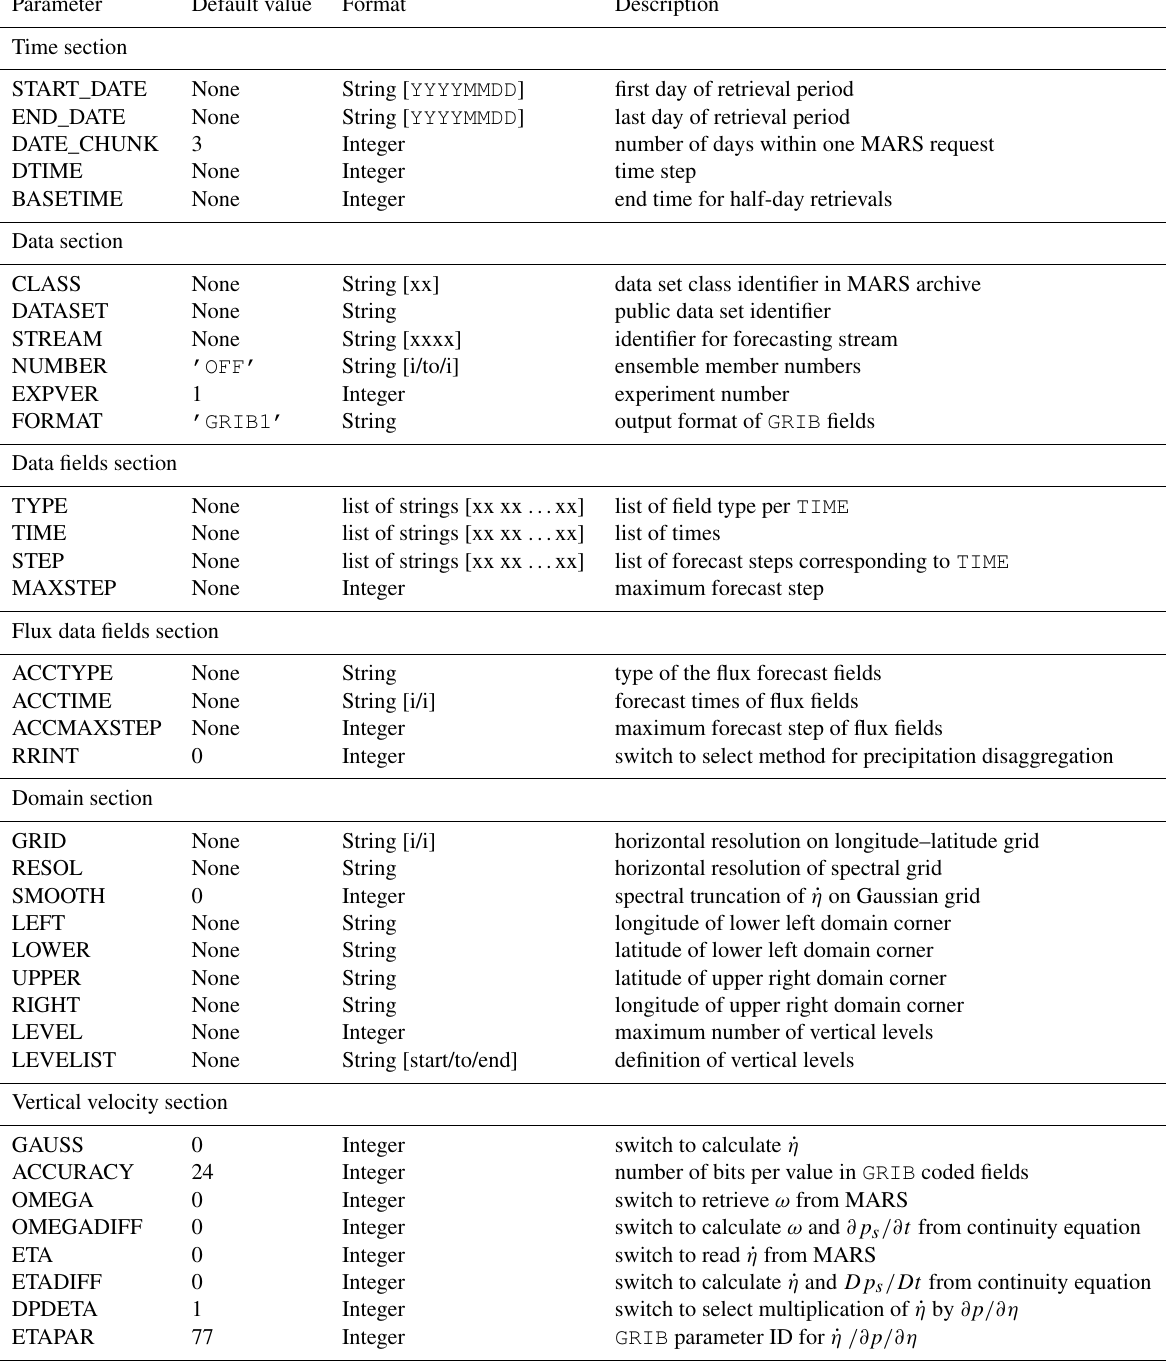
Table 8. Overview of CONTROL file parameters. A more detailed description on parameter handling, setting and value ranges is given in the